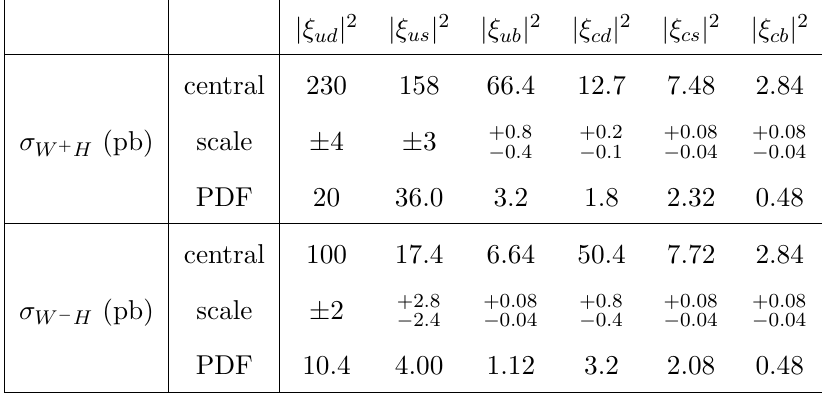
Table 1 . Corrections to the W (cid:6) H cross section induced by the RHCC (cid:24) ij at total cross section is (cid:27) = (cid:27) SM + P a ij j (cid:24) ij j 2 , where the sum is over all light quarks. The W (cid:6) H W (cid:6) H values and theoretical uncertainties of a ij are given in the